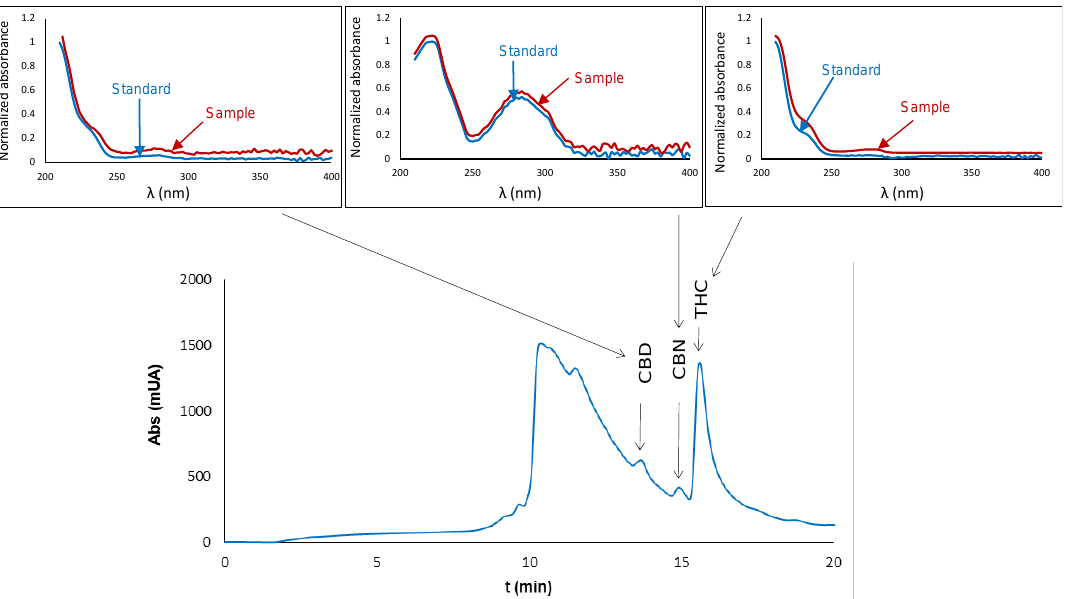
Figure 2. Chromatogram obtained in the analysis of residues of cannabis (sample M1, 0.82 mg), and comparison of the spectra obtained for the peaks of the suspected cannabidiol (CBD), cannabinol (CBN), and THC and those of standard solutions. The methanolic extract collected after processing the swab was diluted 1:5 with ultrapure water before the IT-SPME-nanoLC step. Conditions used for IT-SPME and chromatographic analysis were identical to those indicated in Sections 4.3 and 4.2, respectively.